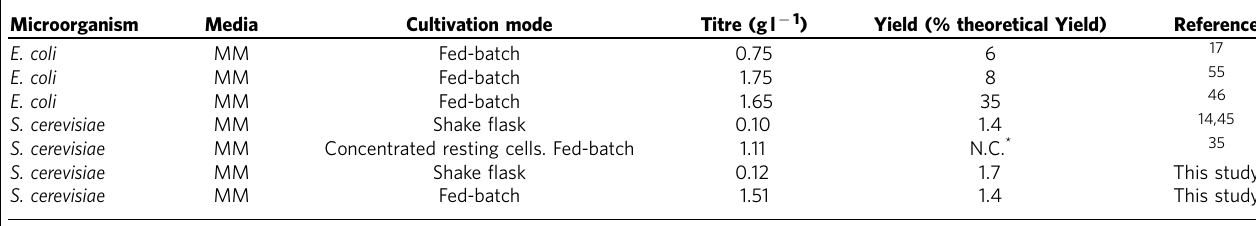
Table 2 | Comparison of cell factories for production of fatty alcohols. Microorganism